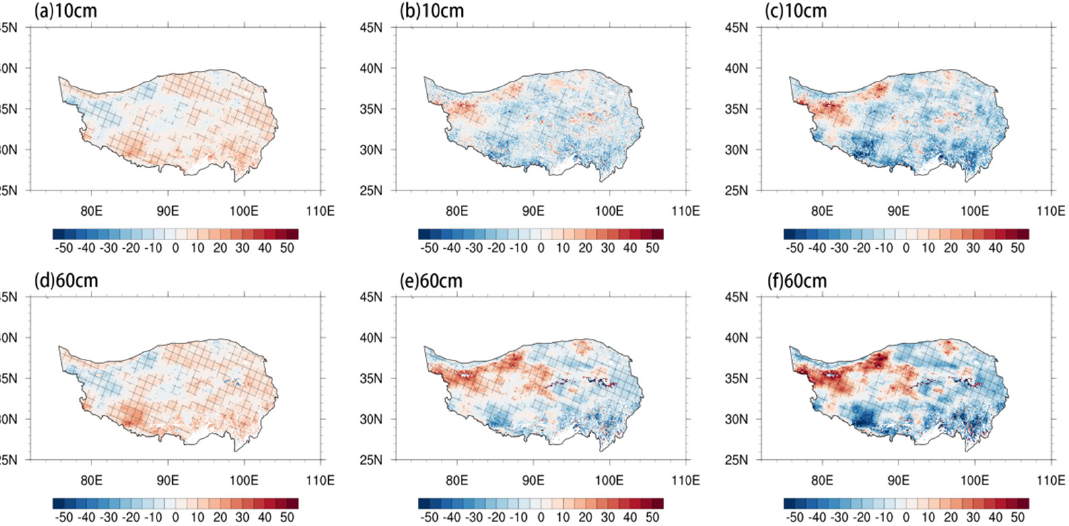
Figure 11. Differences in freezing date, thawing date, and freeze–thaw duration at two soil depths between the RW and RC periods (unit: day). Table 3. Differences in soil freeze–thaw processes between the RW and RC periods (unit: day). Soil